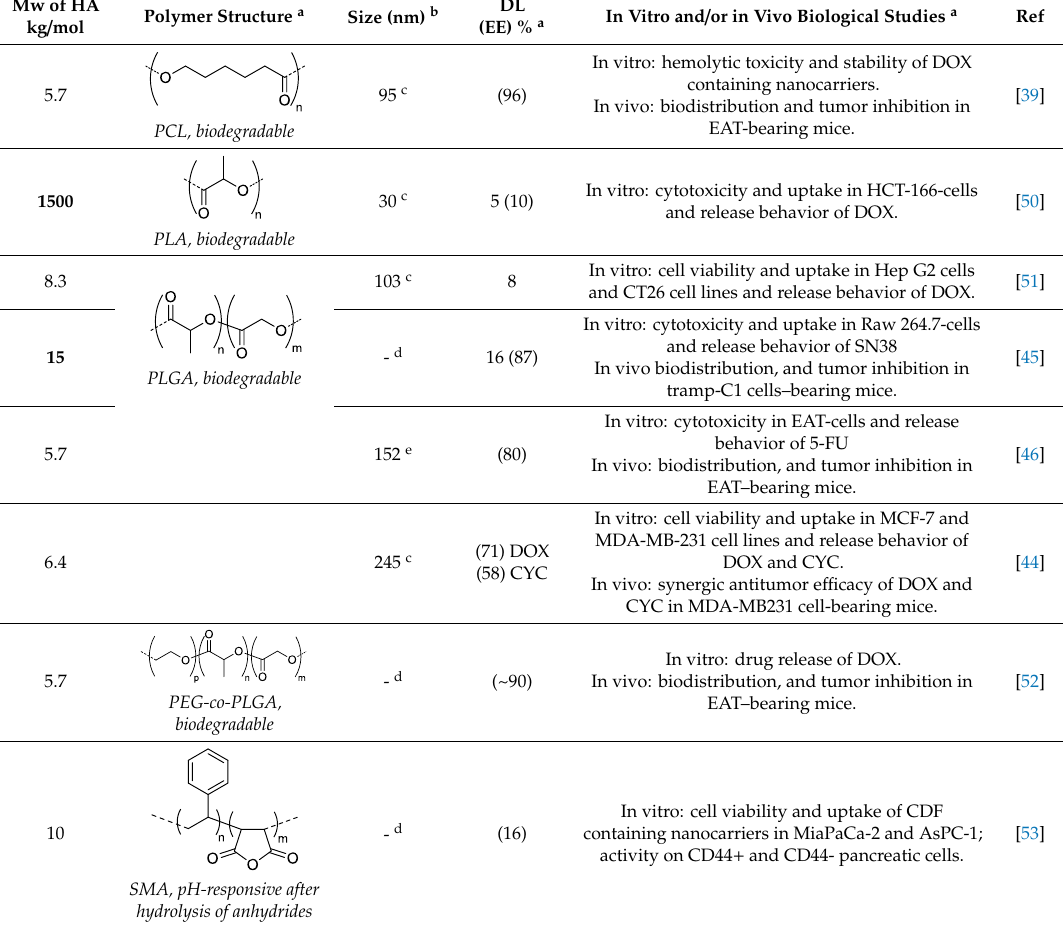
Table 2. HA- g -polymers nanocarriers.